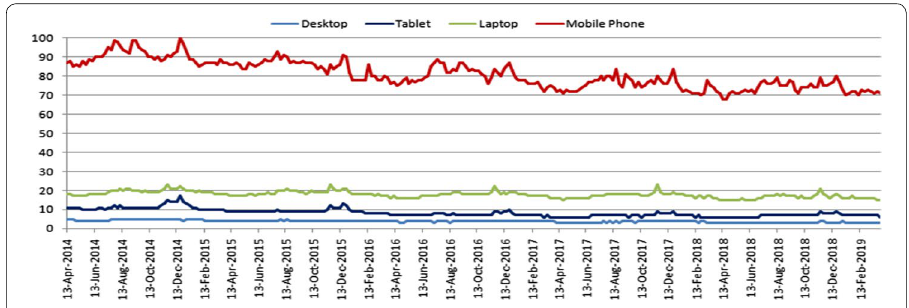
Fig. 1 Users’ interest trends over time, where x-axis and y-axis represent a particular timestamp and corresponding search interests in numeric values in terms of world-wide popularity